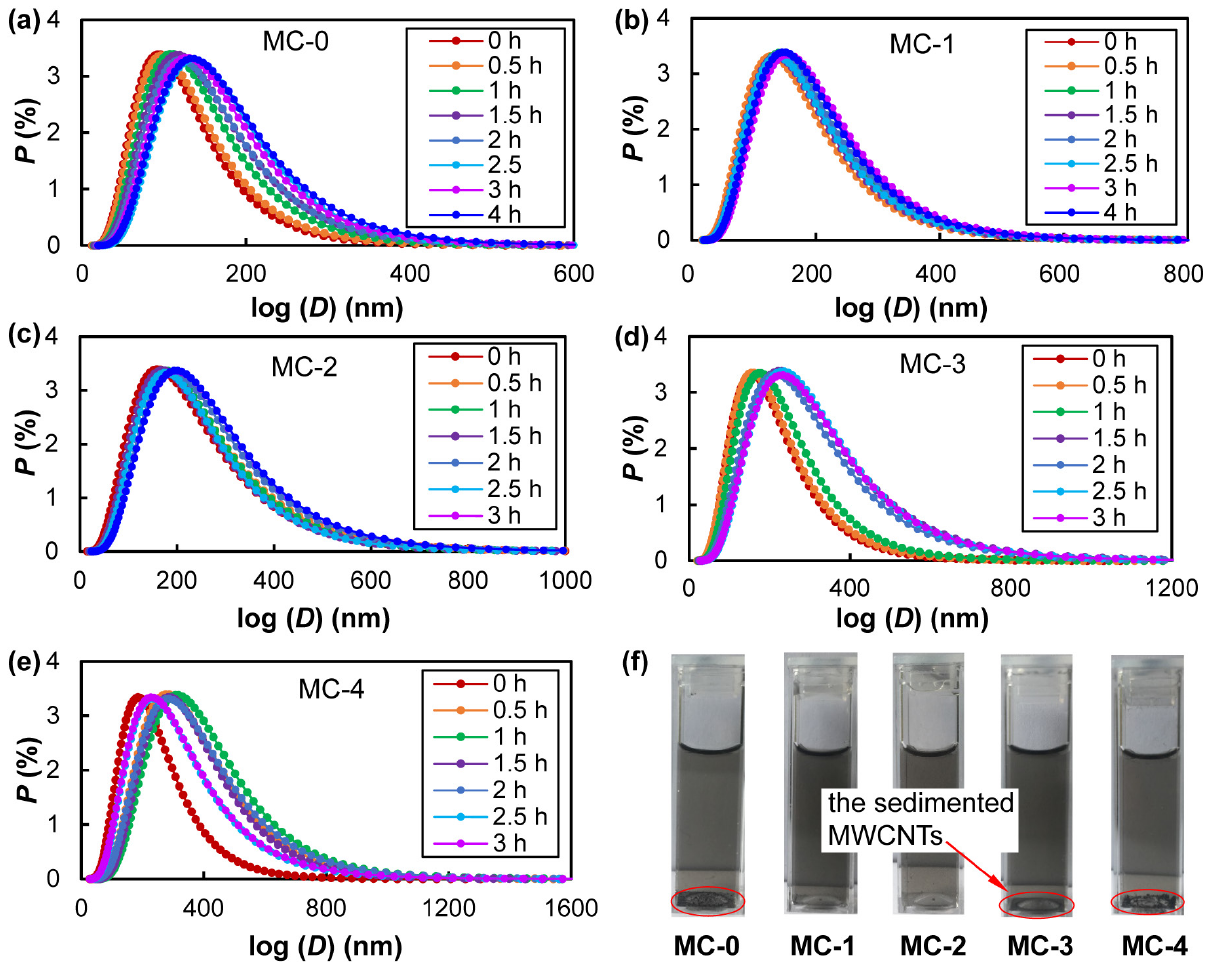
Figure 3: (a)-(e) Probability of log( D ) of nanoparticles in the MC-MWCNT suspensions, (f) visual observation results of the MC-MWCNT suspensions after 120 min